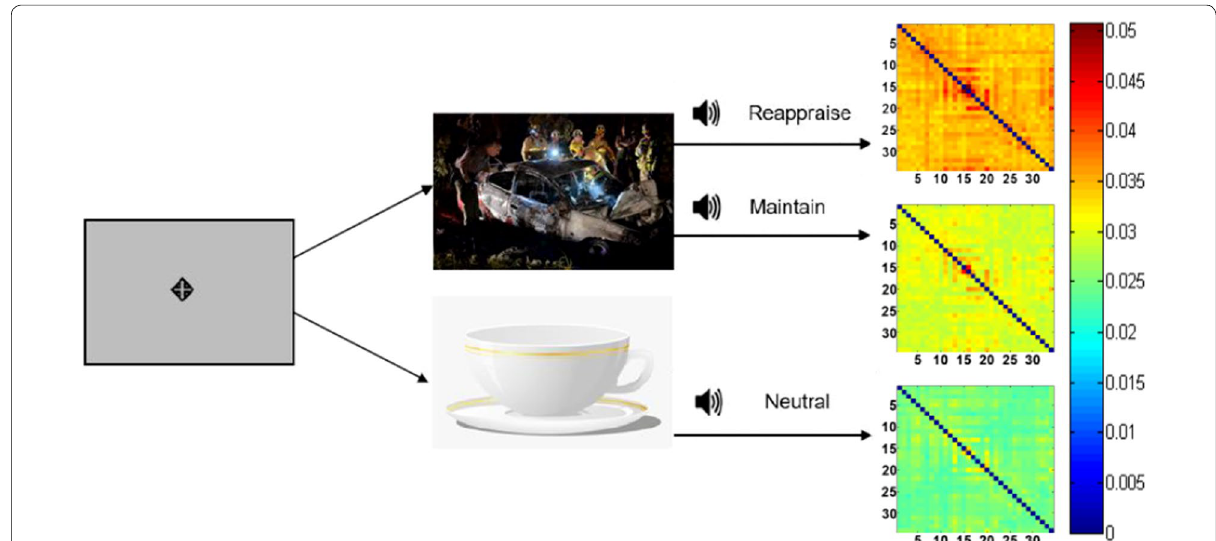
Fig. 1 An illustration of a typical ERT session. A fixation point is on display before each trial, then followed by either a neutral or negative picture on the screen. An audio instruction will ask test subjects to maintain , reappraise or stay